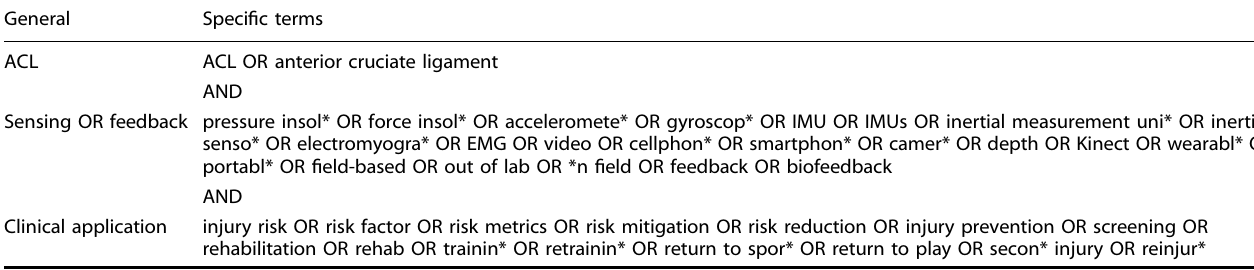
Table 4. Speci fi c search terms used for the literature